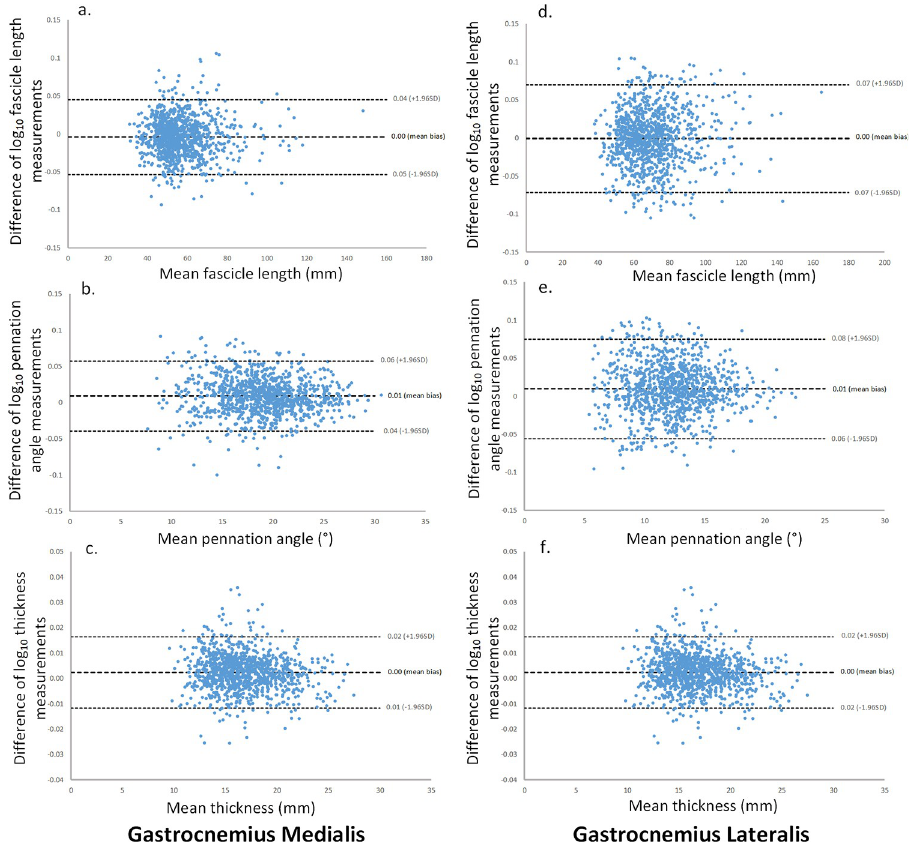
Fig 4. Bland-Altman plots showing the differences between Investigator A and Investigator B log10 measurements in relation to the mean of Investigator A and Investigator B measurements. Dashed lines indicate the mean bias and the upper and lower 95% limits of agreement. Fascicle length, pennation angle, and muscle thickness measurement comparisons for the gastrocnemius medialis are represented by a. b. and c. respectively, and the gastrocnemius lateralis represented by d. e. and